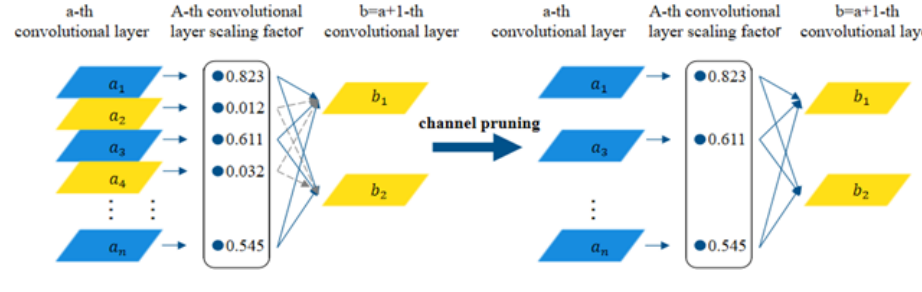
Figure 7. Channel pruning strategy.